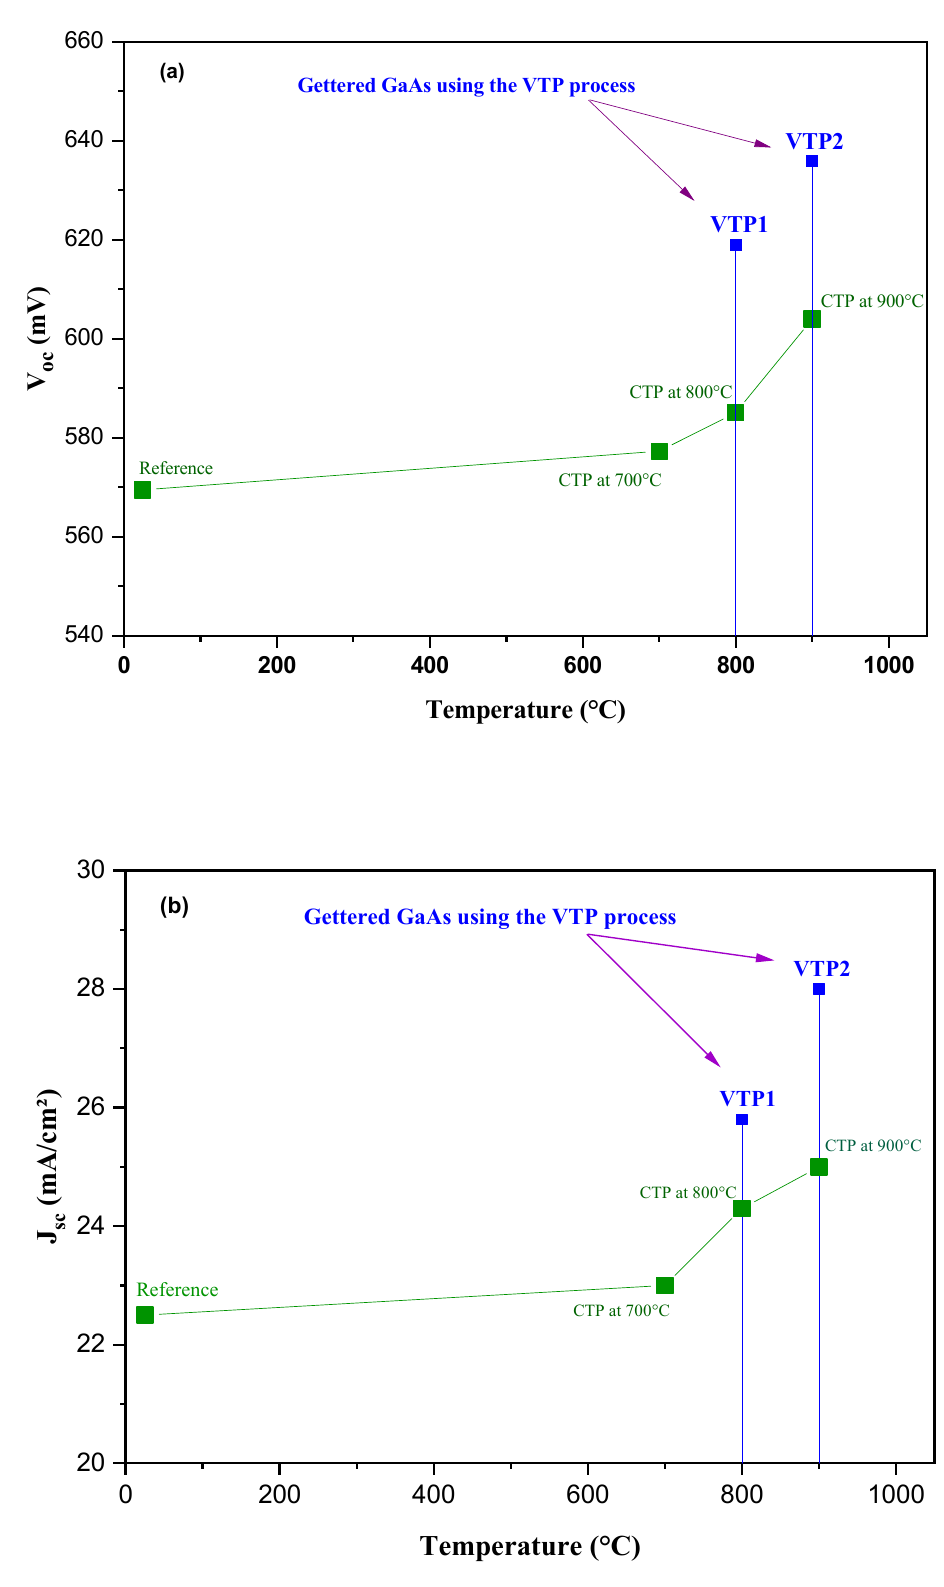
Figure 4. ( a ) Dependency of the open circuit voltage (V oc ) and ( b ) the short circuit current density (J sc ) with the gettering temperatures during the infrared (IR) rapid thermal process (RTP),